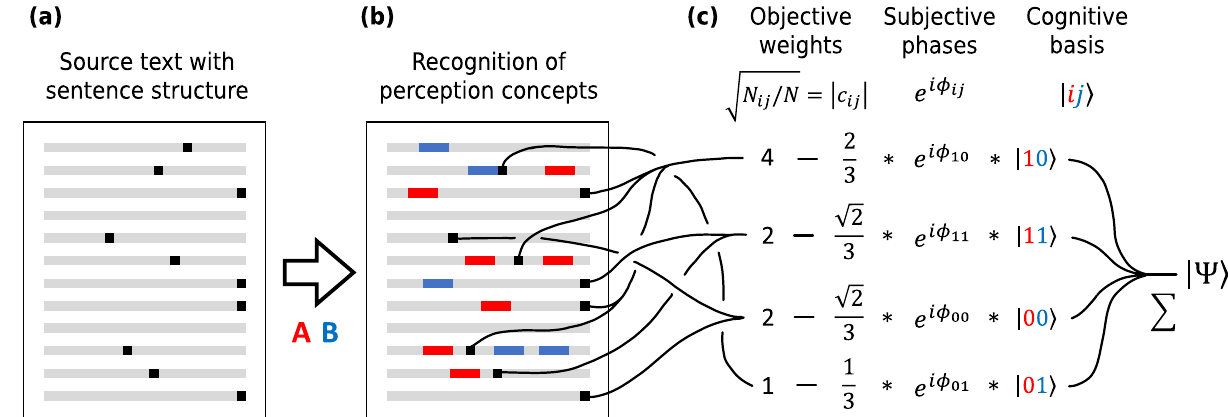
Figure 2. Text perception model: construction of the quantum cognitive state from the text substrate. Source document with sentences delimited by black squares ( a ) is perceived through binary distinctions expressed by concepts A and B. Presence of words associated with A and B (identified with neighboring sets, see Calculation of amplitudes) marked by red and blue ( b ) categorizes sentences to semantic subspaces defined by distinction states (Table 1). Number of sentences in each category defines absolute values of the amplitudes (cid:31) in cognitive state (4). The model is finalized by supplementing the amplitudes with phase factors e i φ ij | � representing subjective dimension of text perception ( c